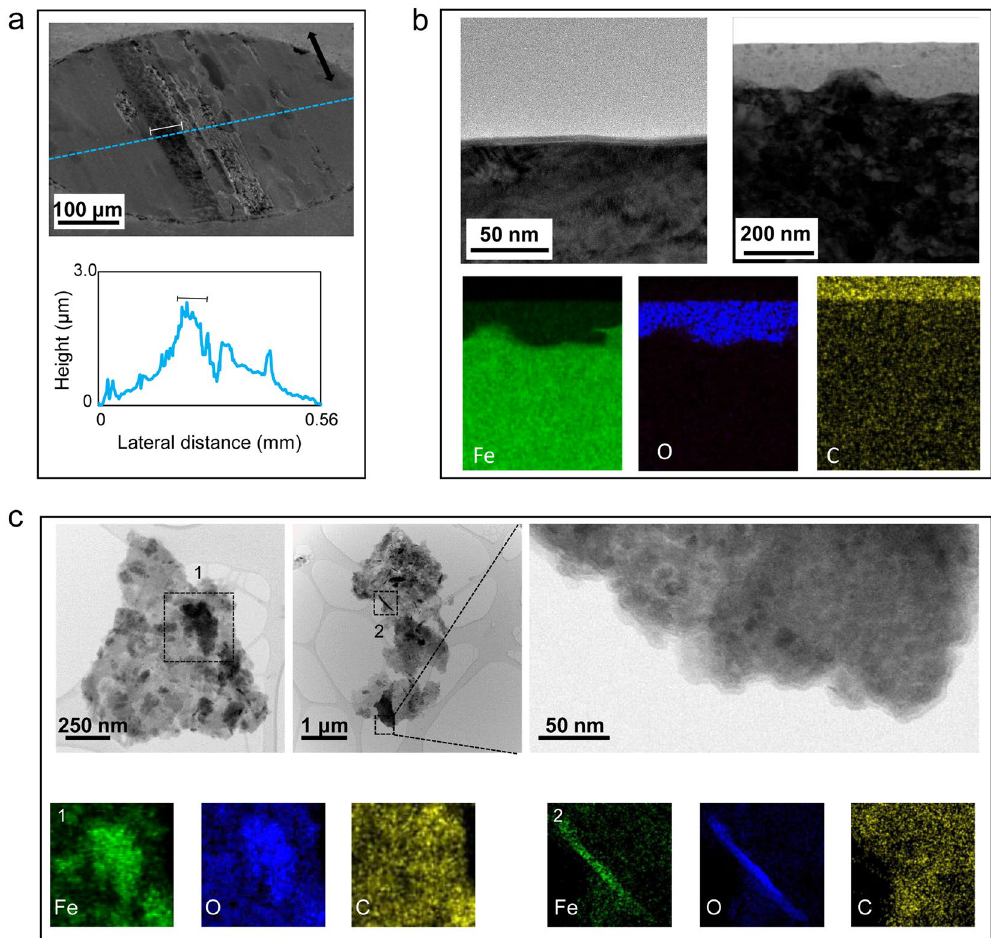
Figure 4. Worn surface on the steel ball lubricated by the neat base oil and the collected wear debris particles. ( a ) SEM image of the ball wear scar with a 2D profile (marked protrusion indicating adhesive material buildup). ( b ) Cross-sectional BF-STEM images of the worn surface showing a thin iron oxide film and an adhesive material buildup. ( c ) BF-STEM images of aggregated wear debris particles, with a magnified view of a cluster of fine nanoparticles. EDS elemental maps indicating mixed iron oxides and metallic iron.